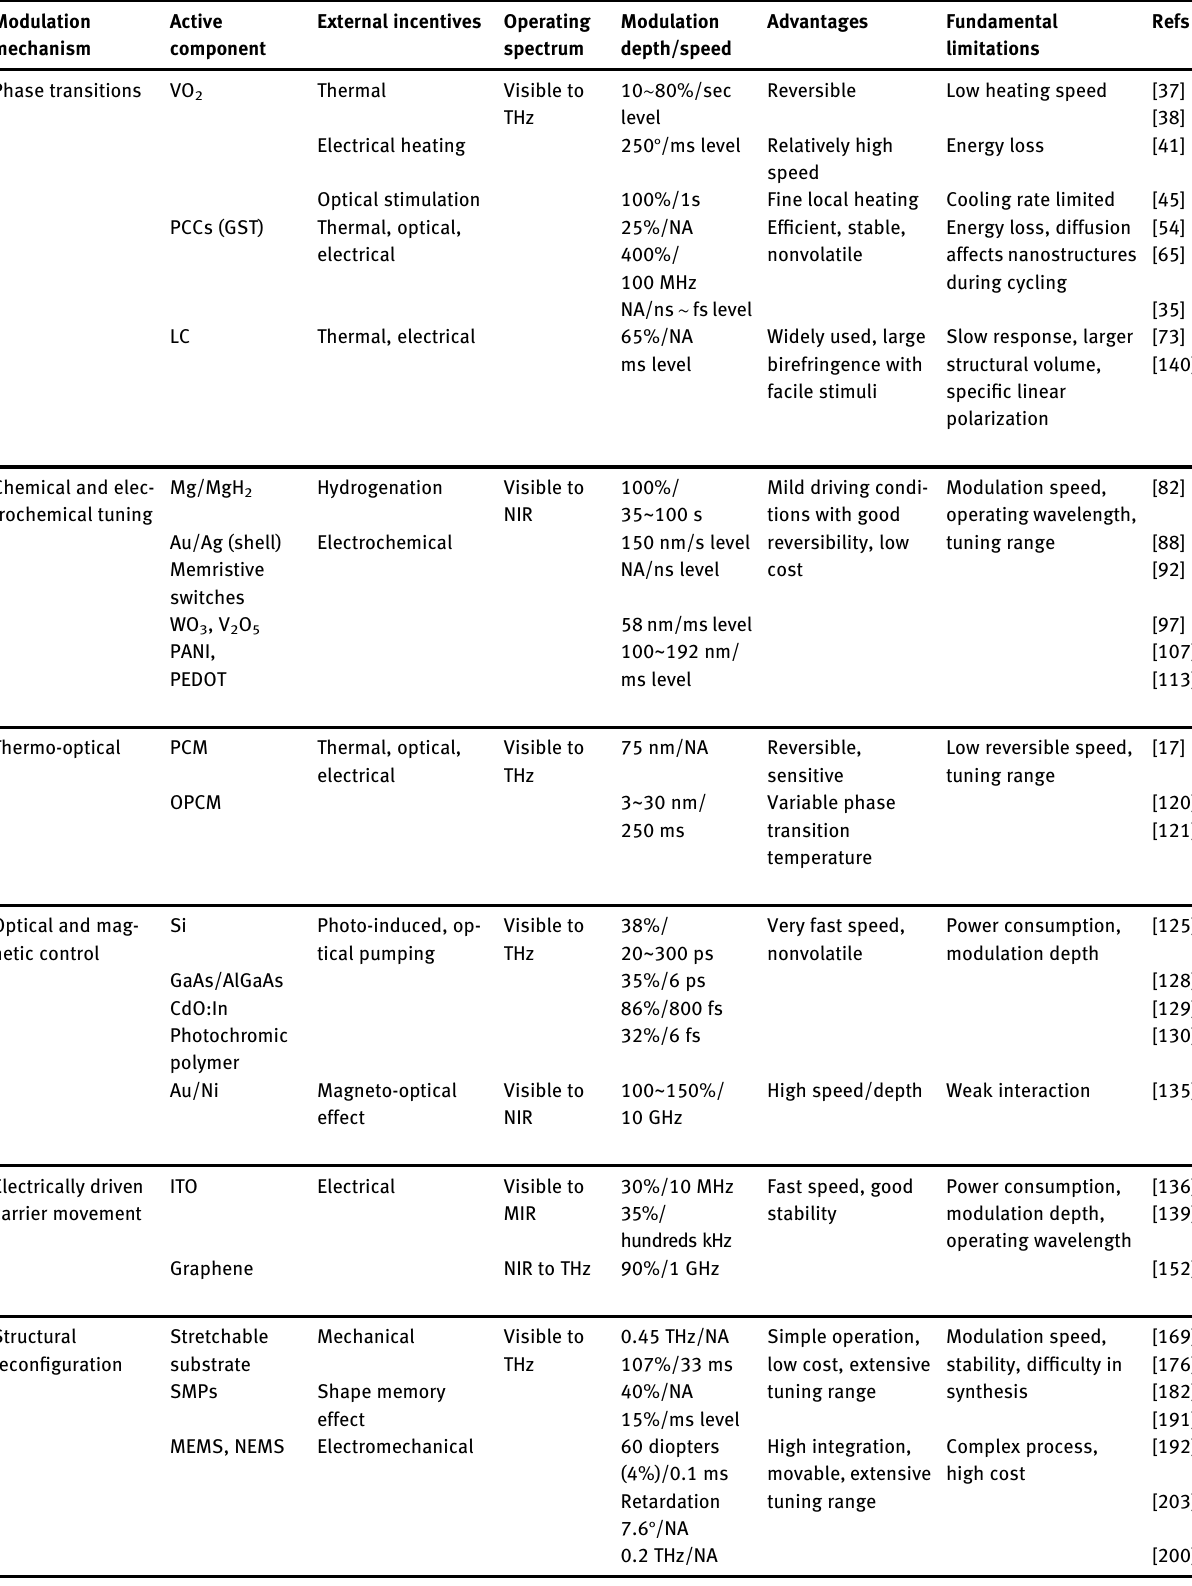
Table  : Comparison of multiple modulation mechanisms to achieve tunable optical